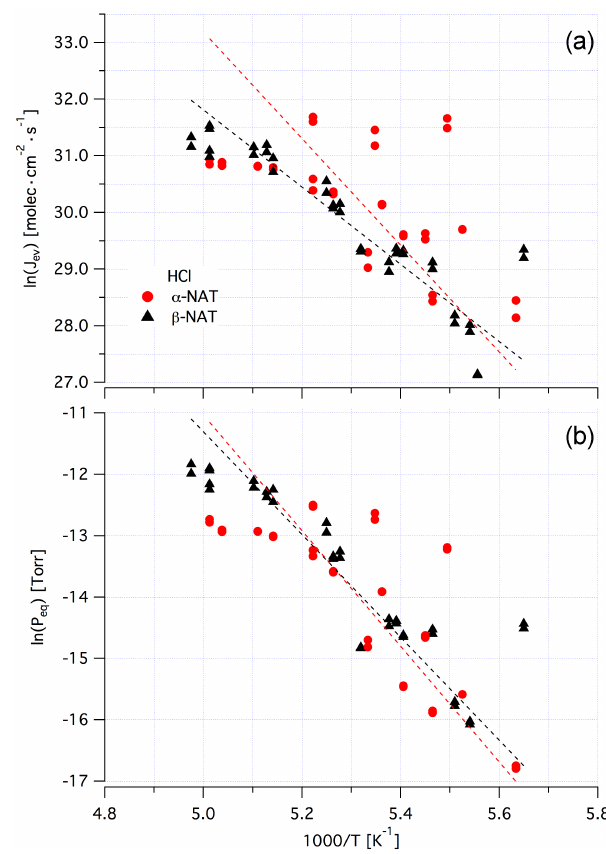
Figure 14. Arrhenius plot of J ev (HCl) (a) and van’t Hoff plot of P eq (HCl) (b) for α -NAT (Fig. 8b and c) and β -NAT (Fig. 9b and c) resulting from PV experiments. Full red circles and black triangles represent the interaction of HCl with α - and β -NAT films, respec- tively. The equations for the fitting lines may be found in the text.